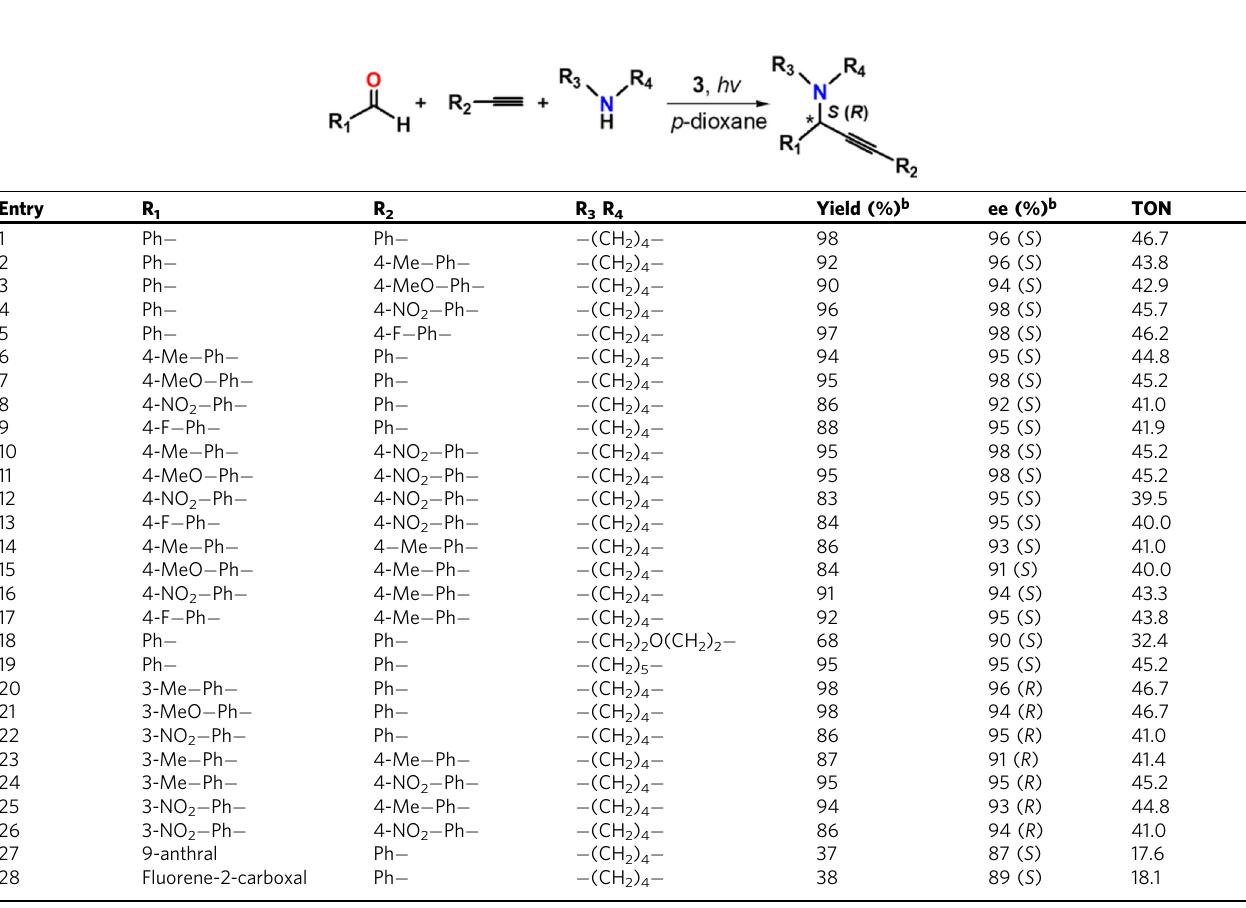
Table 4 Scope of the 3-catalyzed asymmetric A 3 -coupling reactions a